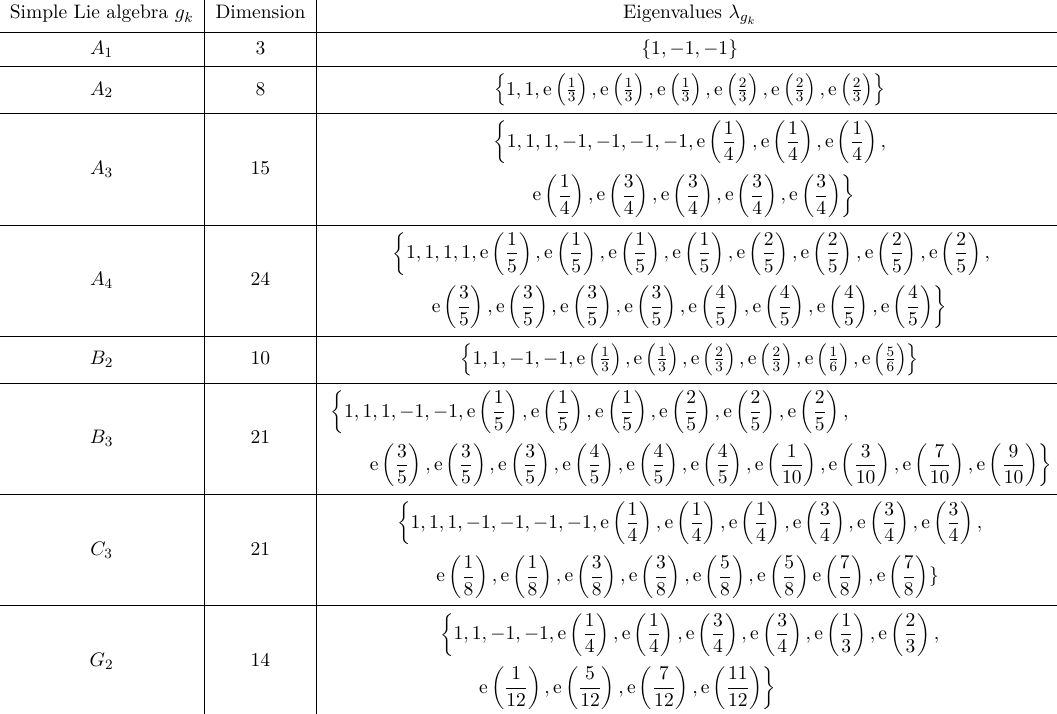
Table 1 . Eigenvalues for symmetries σ g which relate F 24 with g -preserving N = 1 supercurrent to V fE 8 . The 24 eigenvalues λ g of σ g can be decomposed into sets of eigenvalues which act on each simple component of g , such that λ g = ∪ k λ g e( x ) := e 2 πix